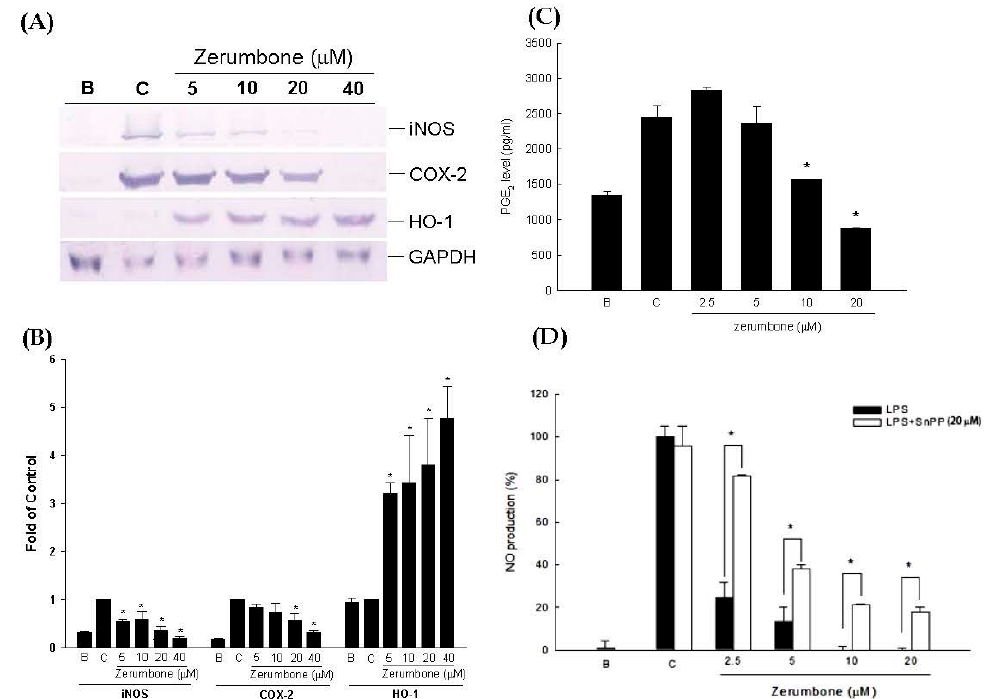
Figure 1. Anti-inflammatory action of zerumbone on lipopolysaccharide (LPS)-stimulated RAW 264.7 cells after treatment for 6 h. ( A ) Inducible nitric oxide (NO) synthase (iNOS),